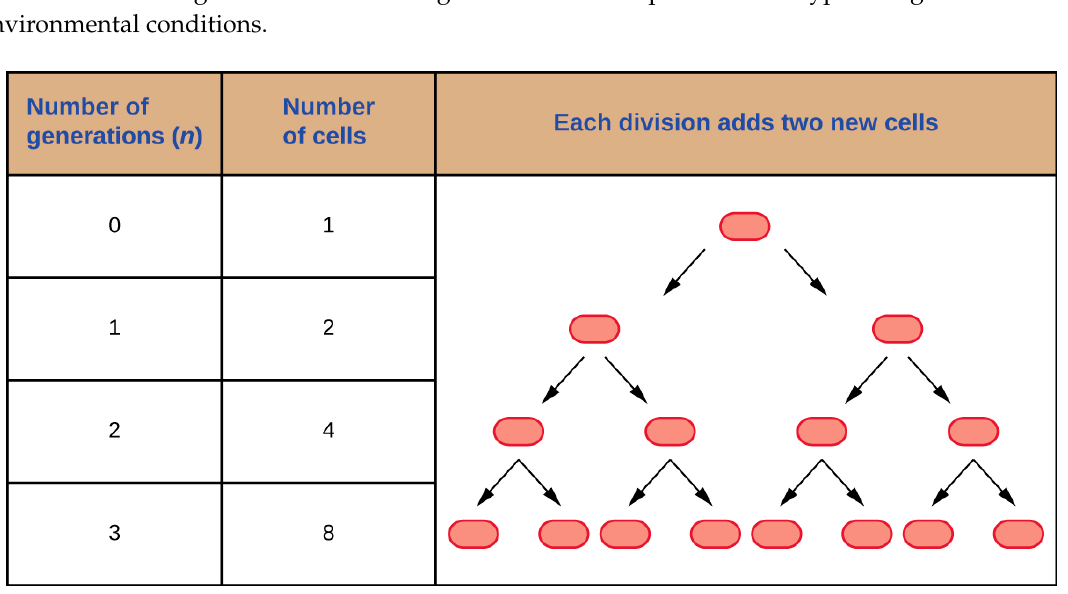
Figure 1. This image displays the binary fission process [17].